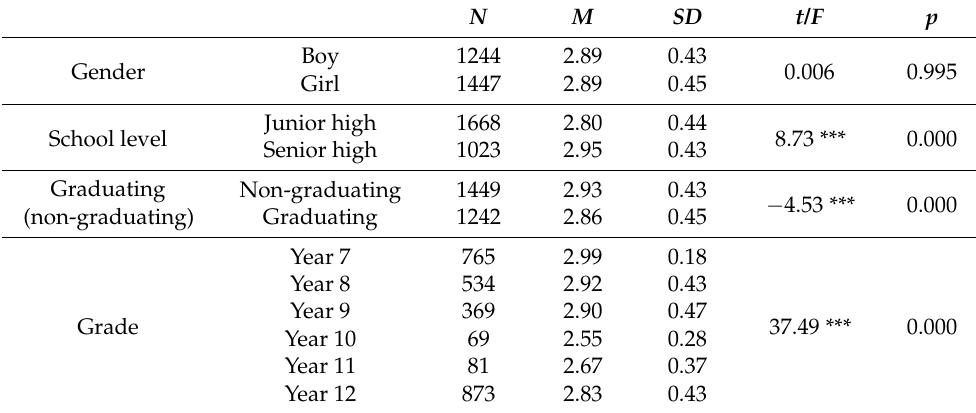
Table 5. ANOVA analysis of mental health.